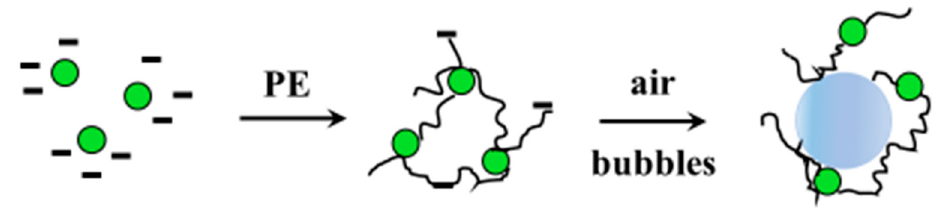
Figure 2. Charge neutralization e ff ects of a hydrophobic cationic PE, followed by its binding to air bubbles.